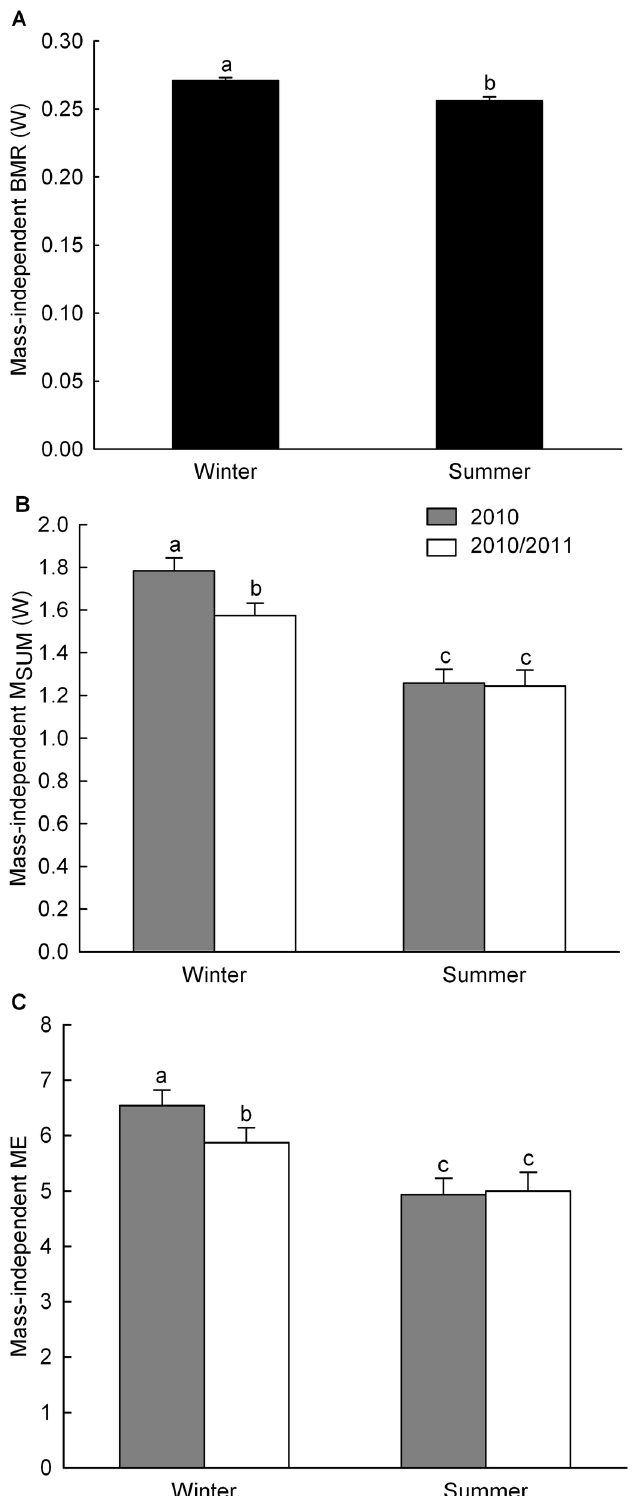
Figure 1. Inter-seasonal variation of mass-independent BMR, M (B) and ME (C) controlling for year, season, sex and body mass with bird ID as random parameter. Different letters indicate significant difference between seasons. doi: 10.1371/journal.pone.0068292.g001 PLOS ONE |